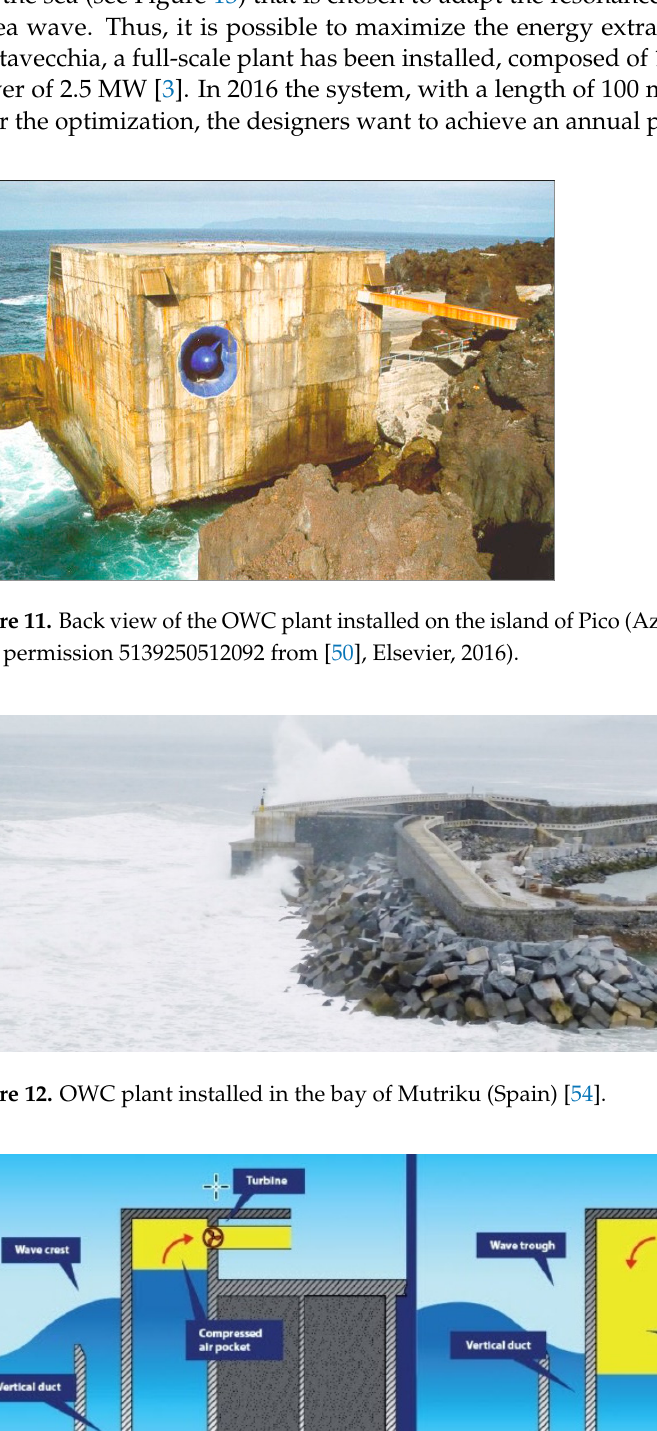
Figure 12. OWC plant installed in the bay of Mutriku (Spain) [54].